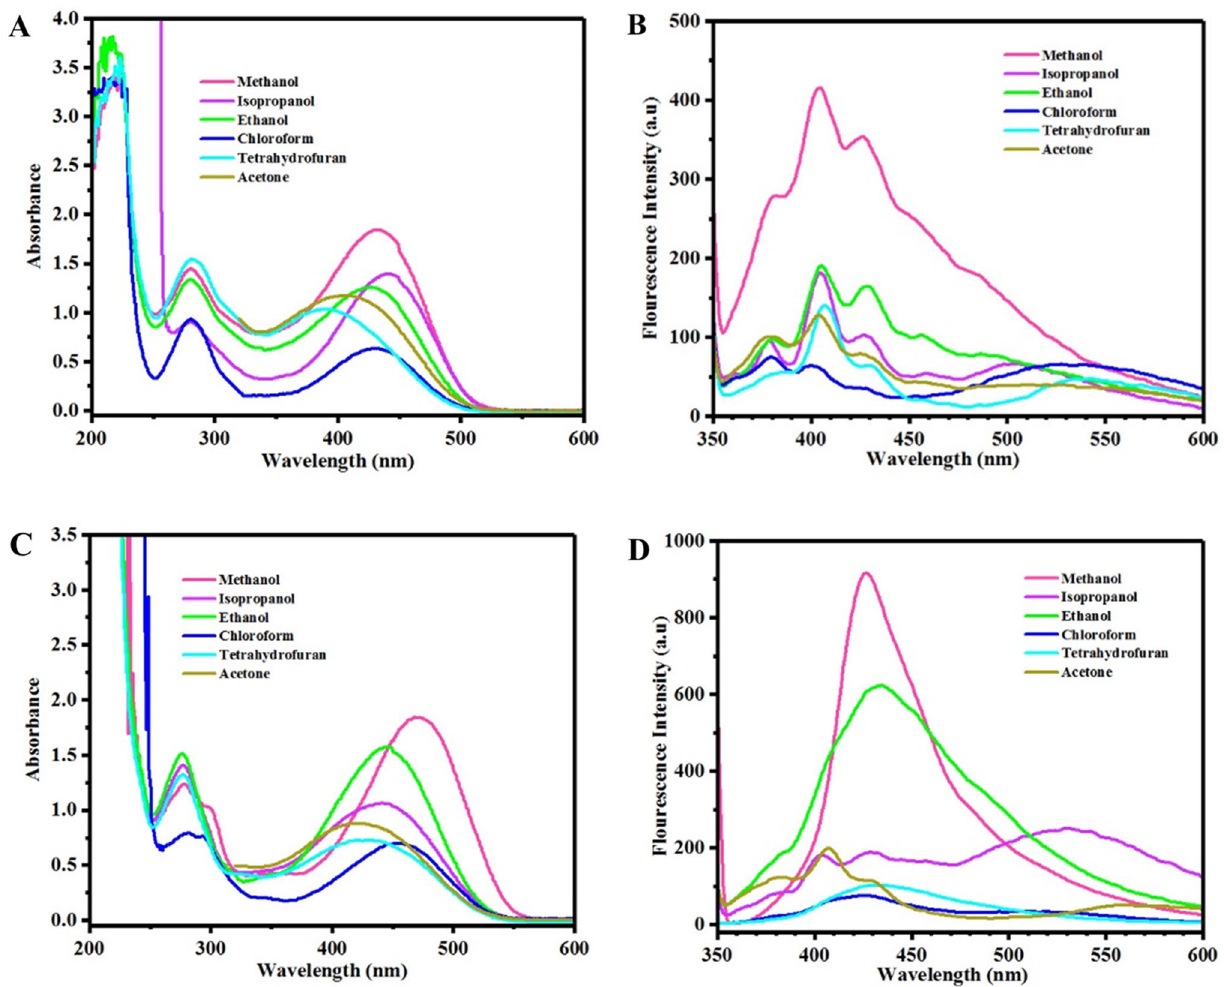
Figure 5. Investigation of solvatochromism behavior in different solvents in UV–Vis and fluorescence spectroscopy for ( A ) and ( B ) OX 1 -Naph and ( C ) and ( D ) OX 2 -Naph